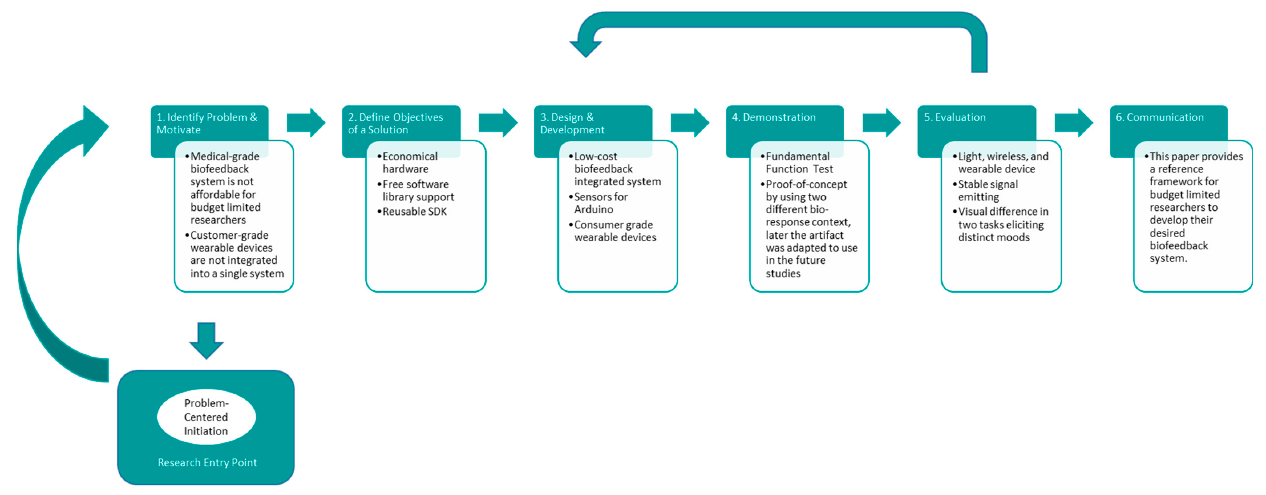
Figure 1. The development procedure of the low-cost biofeedback platform using the design science research